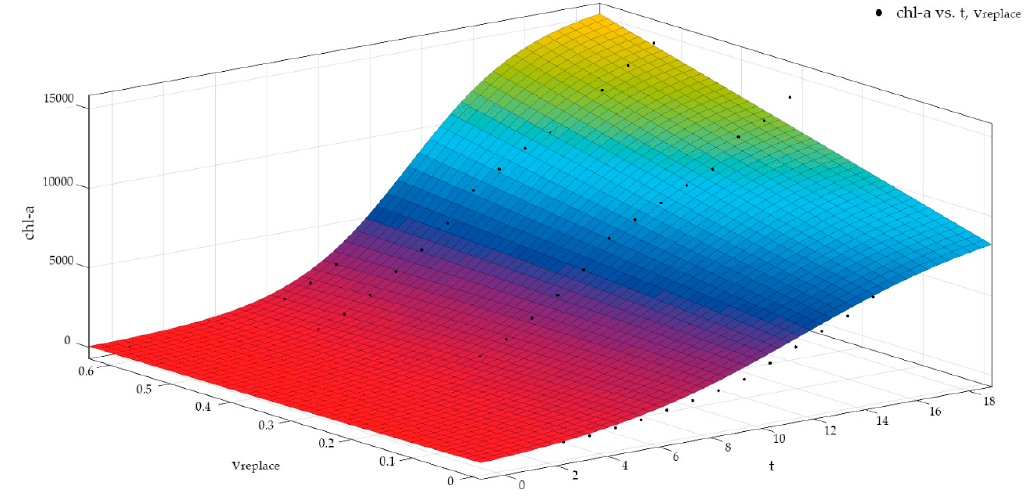
Figure 7. Relationship among hydrodynamic impact factor, time, and Chl-a concentration.